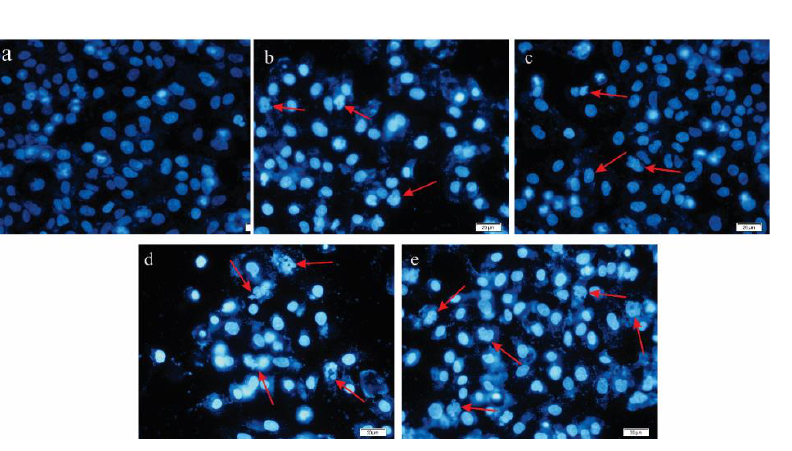
Figure 3. Fluorescent microscopy of DAPI-stained A549 cells (magnification, ×100). Untreated